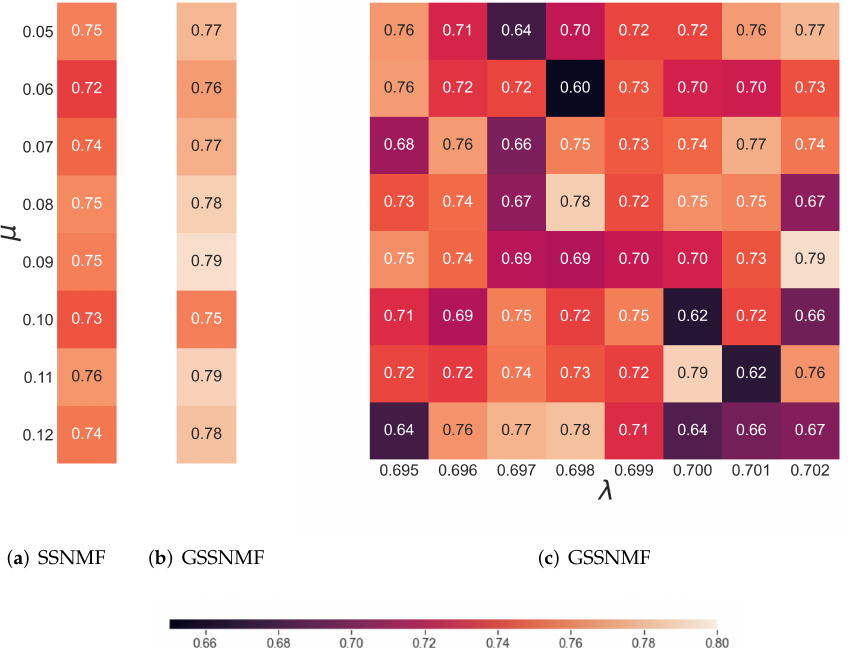
Figure 6. Macro F1-scores for SSNMF and GSSNMF applied to the 20 Newsgroups data, averaged over 10 independent trials with µ ∈ [ 0.05,0.12 ] , λ [ 0.695,0.702 ] : ( a ) displays the results for SSNMF with µ ∈ [ 0.05,0.12 ] ; ( b ) shows the best performance for GSSNMF by ranging λ from 0.695 to 0.702; with µ ∈ ( c ) shows the performance of GSSNMF with different combinations of µ and λ in the predefined range. From the maximal values and heatmap, one can see, for different µ , that there are choices of λ such that GSSNMF outperforms SSNMF.